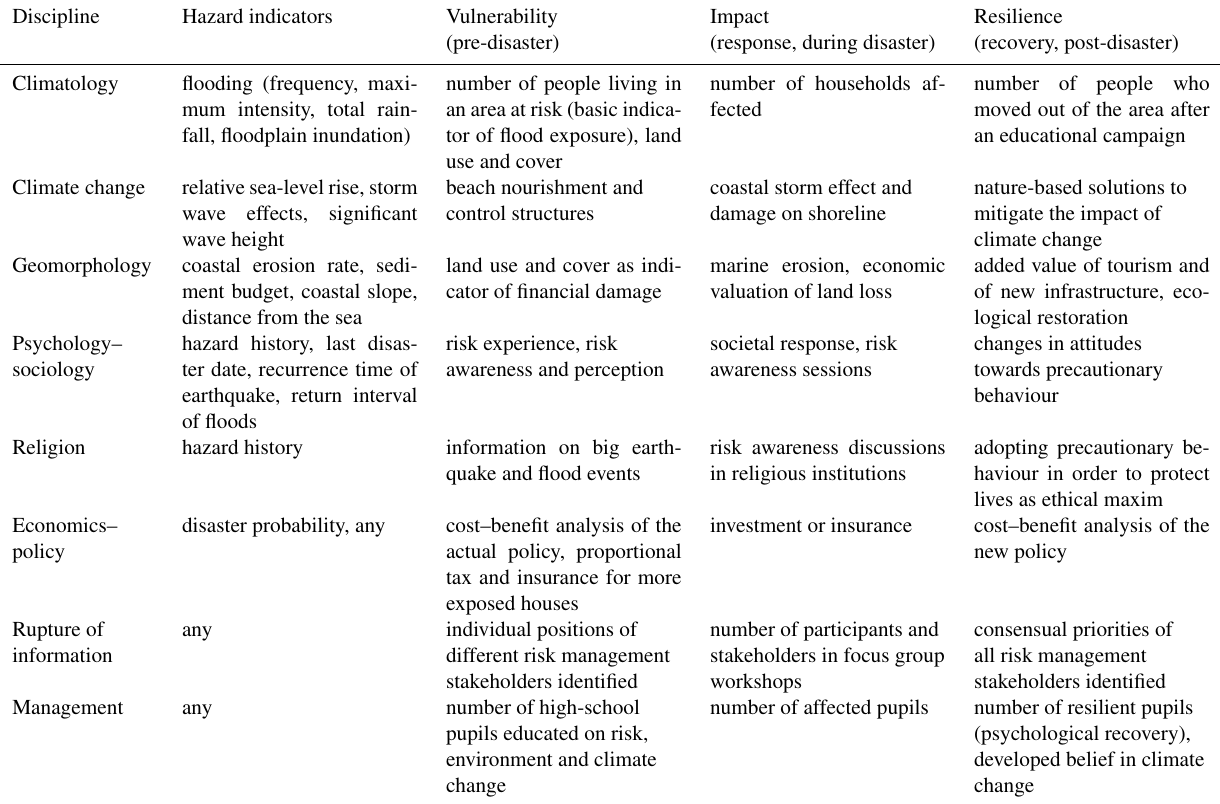
Table 5. Some examples of and ideas for constructing dynamic indicators (adapted from Ivˇcevi´c, 2020).